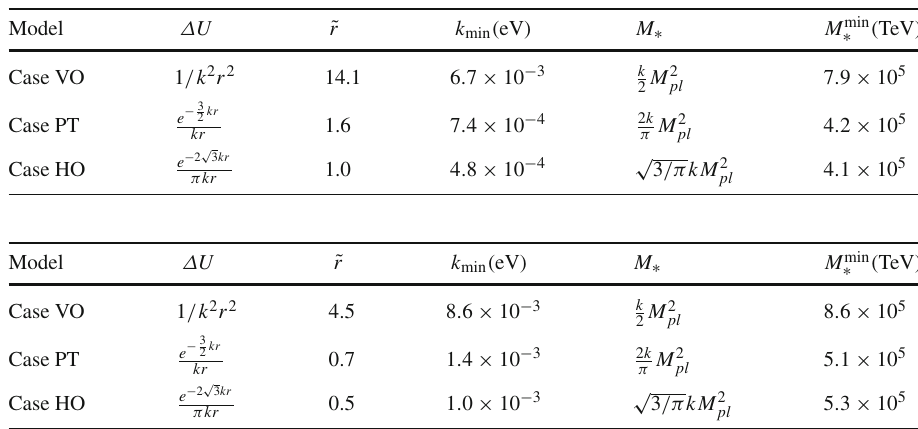
Table 1 Constraints of the scale parameter k and the fundamental M ∗ for the three cases at r = 210 µ m